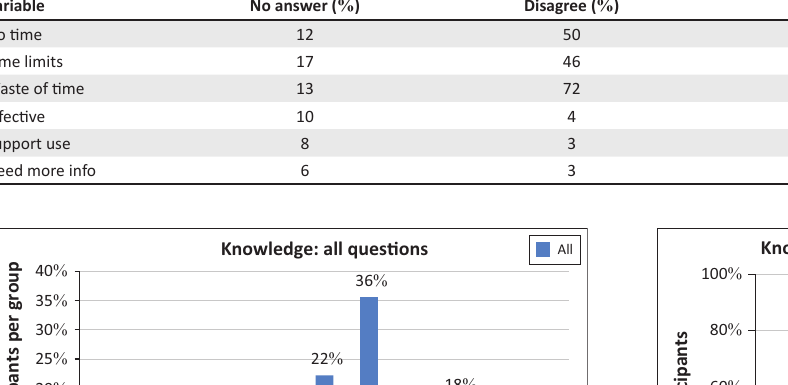
TABLE 4: Participants’ opinions of otoprotective strategies (quantitative data). Variable